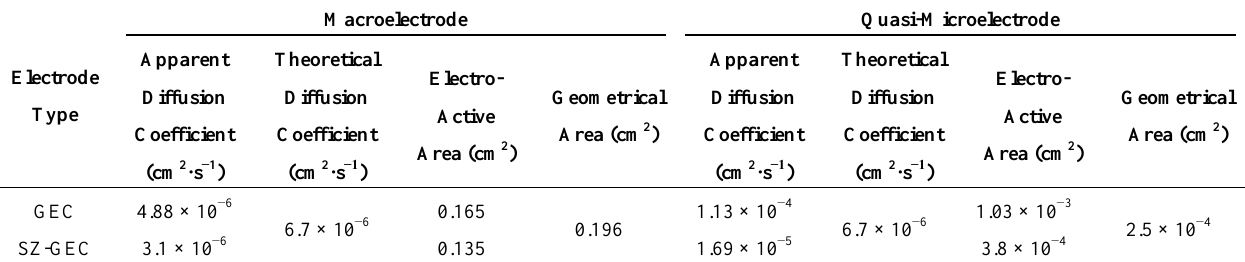
Table 1. Apparent diffusion coefficients and electroactive surface areas of GEC and SZ-GEC macroelectrodes and quasi-microelectrodes.